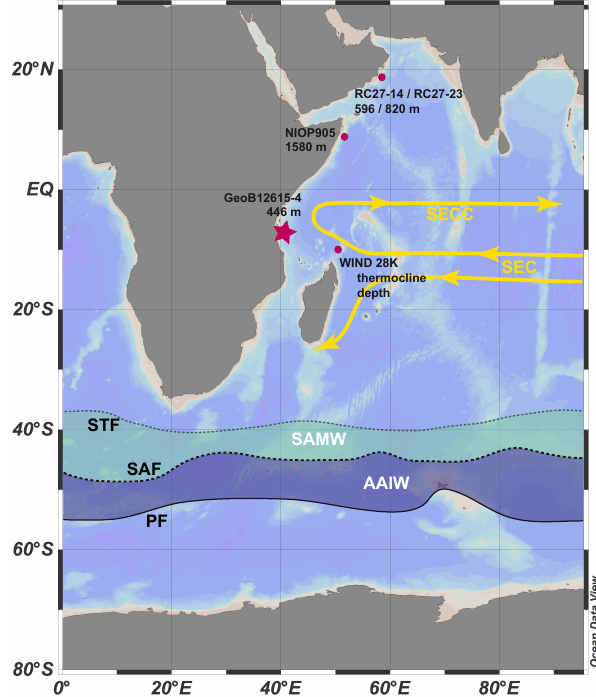
Fig. 1. Location map of sediment core records from the Indian Ocean discussed in this paper. Oman cores RC27-14 and RC27- 23 (Bryan et al., 2010), Somalia core NIOP905 (Jung et al., 2009), Tanzania core GeoB12615-4 (this study) and Madagascar core WIND28K (Kiefer et al., 2006). Hydrographic fronts and forma- tion area of intermediate water masses: STF: Subtropical Front; SAF: Subantarctic Front; PF: Polar Front; SAMW: Subantarc- tic Mode Water; AAIW: Antarctic Intermediate Water; SEC and SECC: South Equatorial Current and South Equatorial Countercur- rent. Redrawn after Pena et al. (2013) and Schott et al.